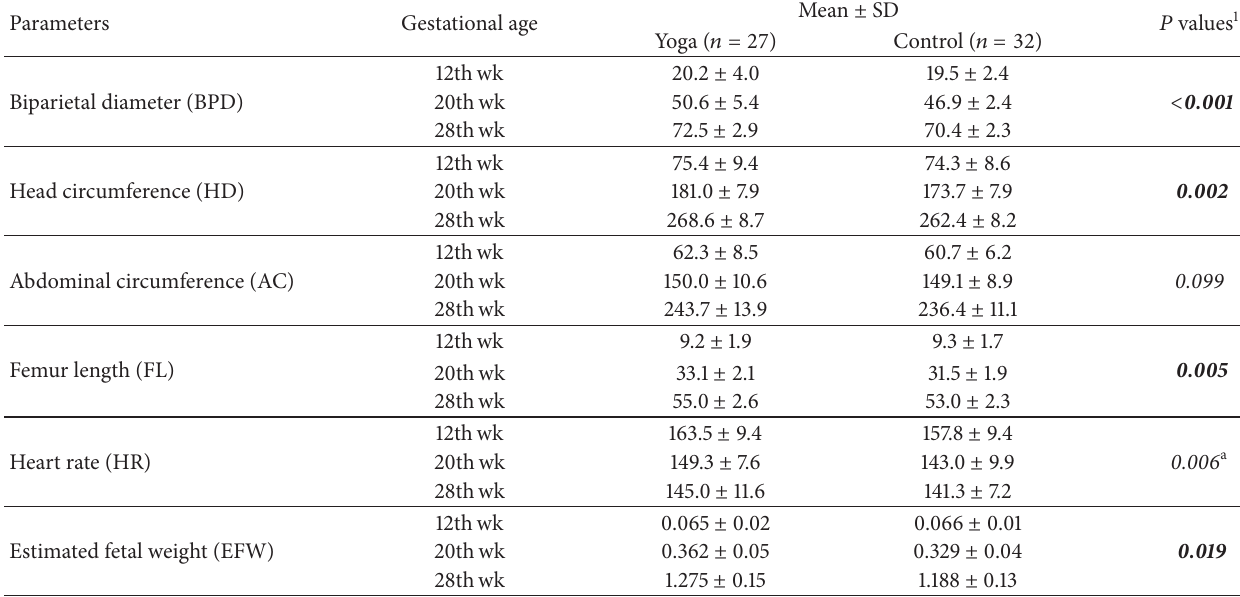
Table 3: Ultrasound fetal measurements between groups.